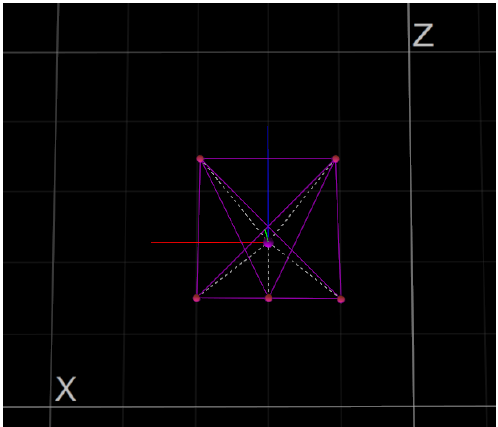
Figure 9. OptiTrack Motive